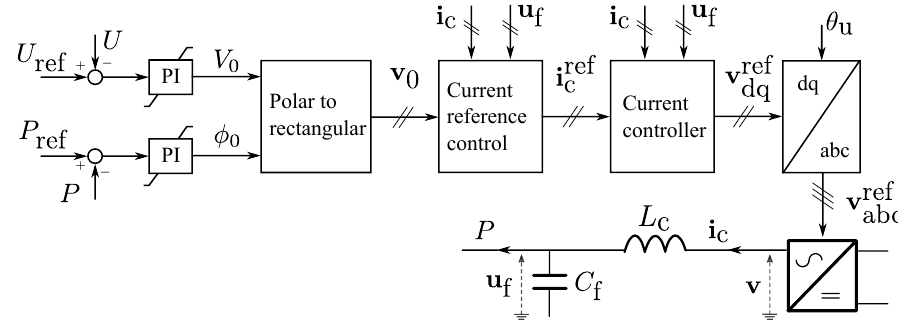
Figure 4. Proposed control scheme used in